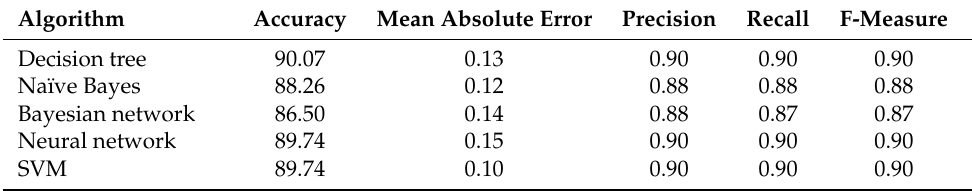
Table 3. Case study 1 results for summation division approach using percentage split.